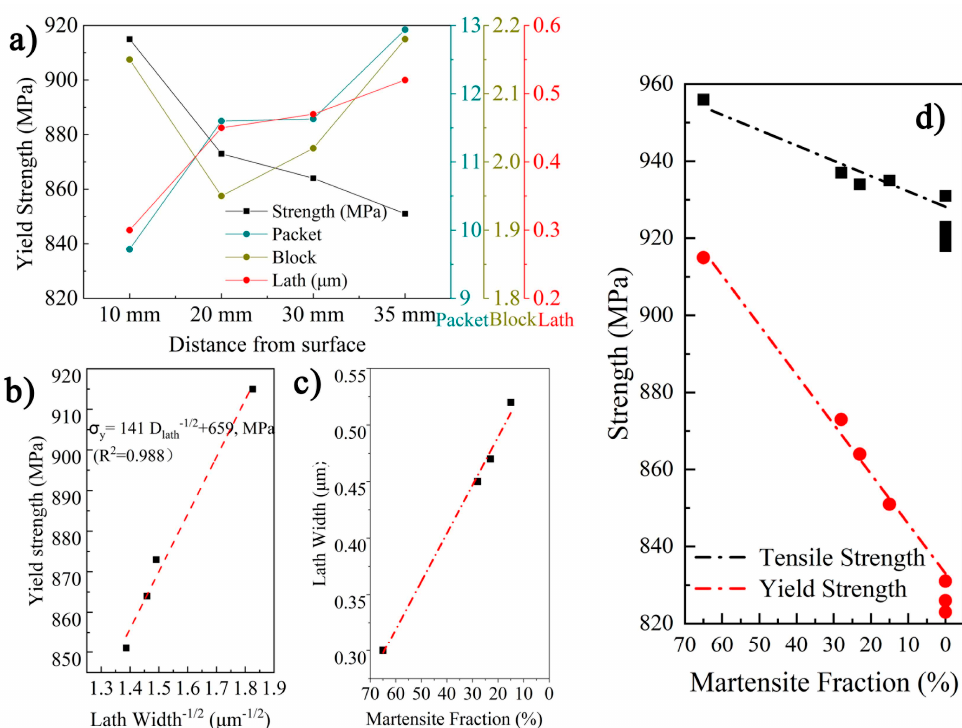
Figure 10. Correlation between microstructure and strength: ( a ) presents the correlation between M/LB substructure size and strength, ( b ) presents a linear relationship between lath width and strength, ( c ) presents a correlation between lath width and martensite fraction and ( d ) presents the correlation between martensite fraction and strength.